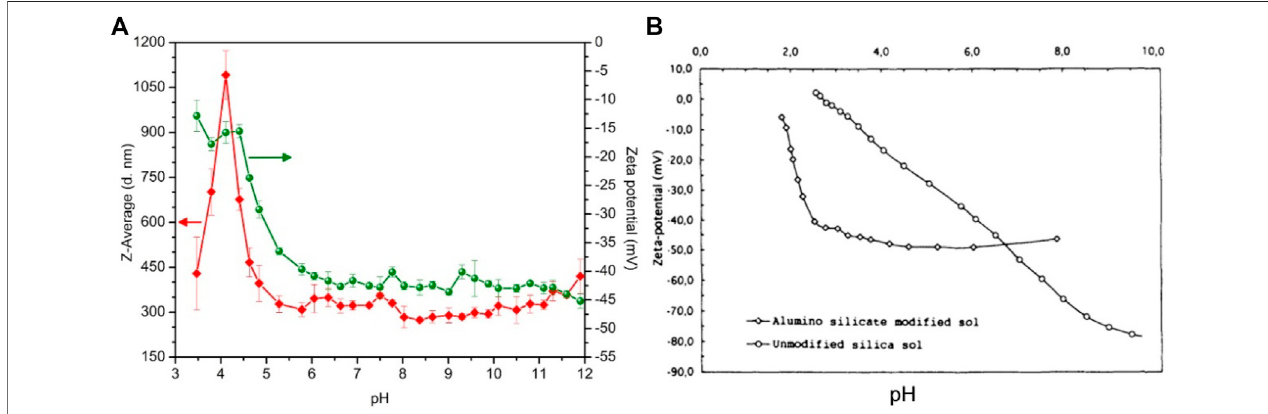
FIGURE 8 | Particle size (red solid diamonds) and zeta potential (green solid spheres) of DGP-W as a function of pH, from this study (A) , and zeta potential of unmodi fi ed (black open circles) and aluminosilicate modi fi ed silica sol (black open diamonds) as a function of pH (B) , modi fi ed from Otterstedt (1998).